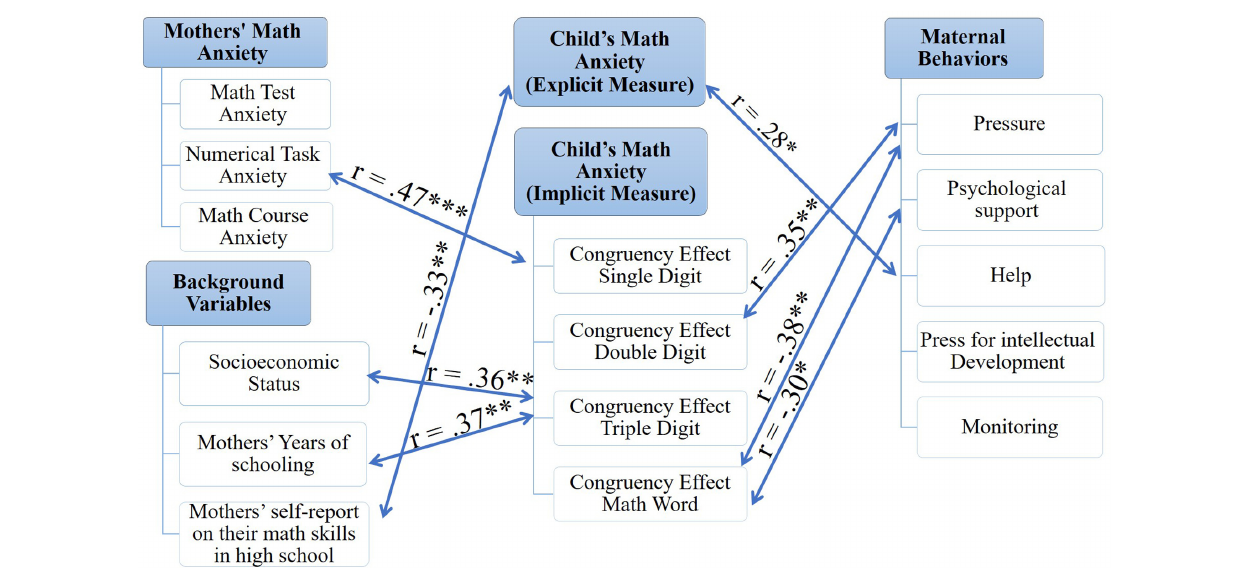
FIGURE 4 | A schematic summary of the correlations between mothers’ variables and children’s math anxiety. ∗ p ≤ 0.07, ∗∗ p < 0.05, ∗∗∗ p < 0.01 (one-tailed).